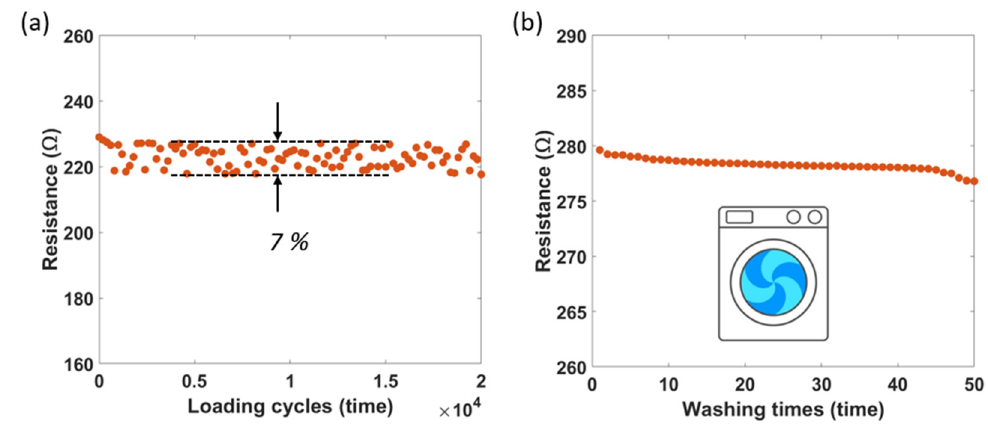
Figure 7. ( a ) Resistance after 20,000 loading/releasing cycles, and ( b ) resistance after 50 washing times